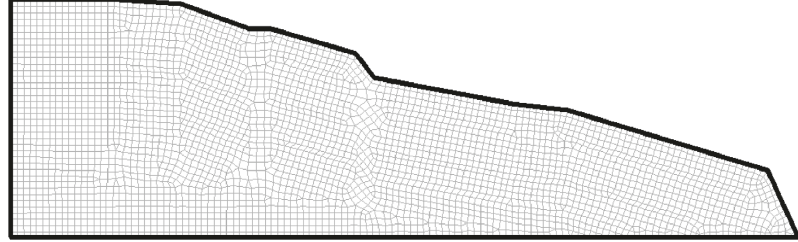
Figure 2: Model Table 1: Physical and mechanical parameters of soil.